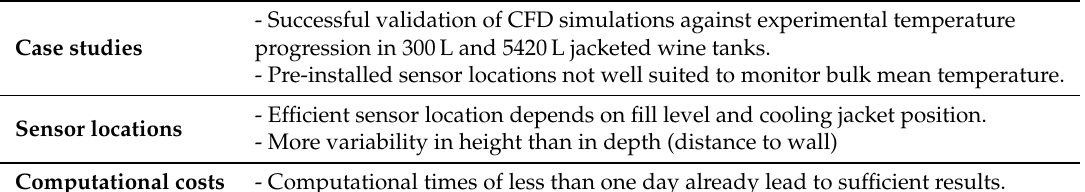
Table 4. Summary of